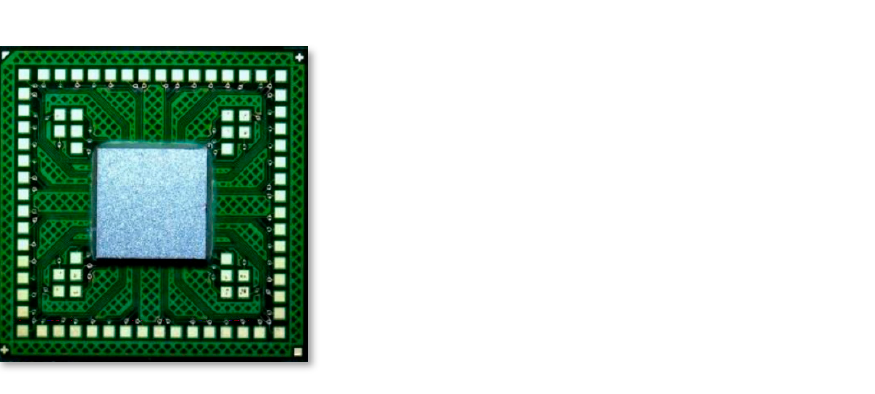
Figure 4. Schematic of bonding process with temperature profile of the TCB process and the post- cure treatment .